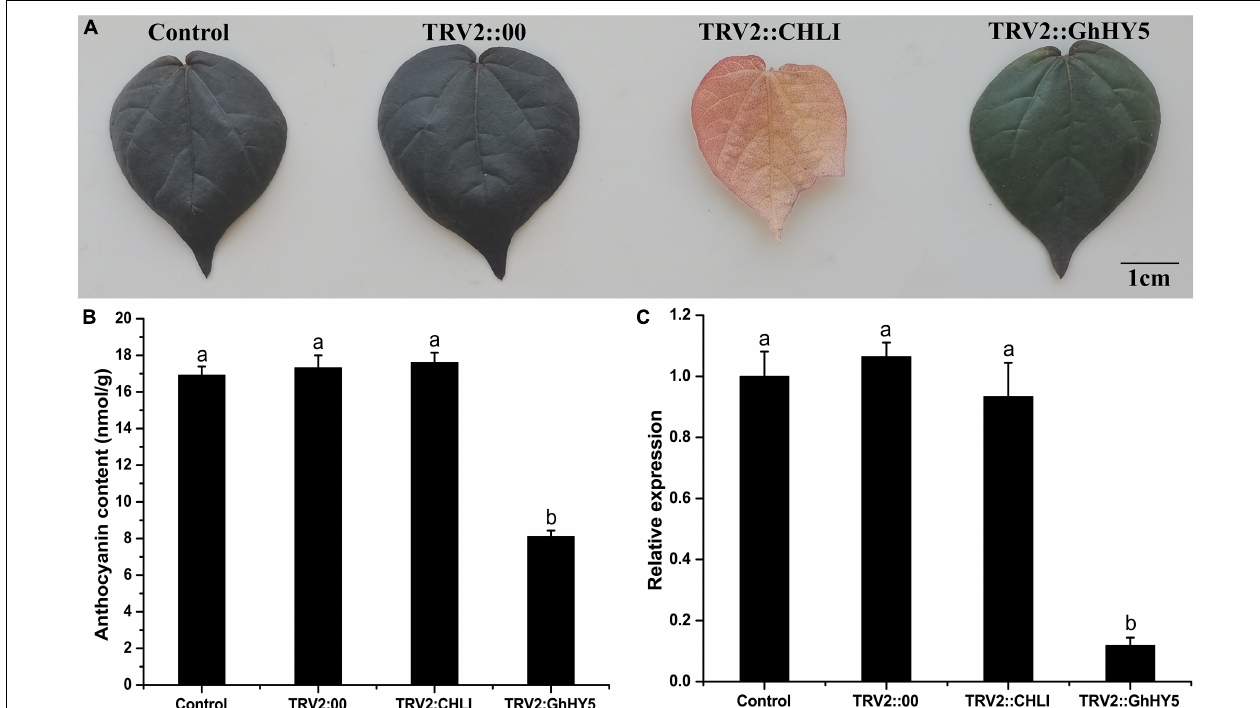
FIGURE 7 | Comparison of leaf color, relative expression level of GhHY5 and anthocyanin contents in the leaves from the VIGS assay. (A) Effect of TRV-VIGS silencing of GhHY5 and GhCHLI in Huiyuan plants on leaf color phenotypes. Control was the untreated Huiyuan leave. TRV2:00 is empty vector. Other two leaves were taken from infiltrated plants 2 weeks post-treatment with the corresponding construct. Scale bar: 1 cm. (B) Anthocyanin concentration in leaves from plants under different treatments. (C) qRT-PCR analysis of GhHY5 expression in leaves from plants under different treatments. GhUBQ7 was used as a control gene. Three biological replicates of each treatment were analyzed. Data are expressed as the means ± SD, n = 3. The letters on top of the bars indicate significance with the same letters being insignificant according to one-way analysis of variance (ANOVA) ( P <